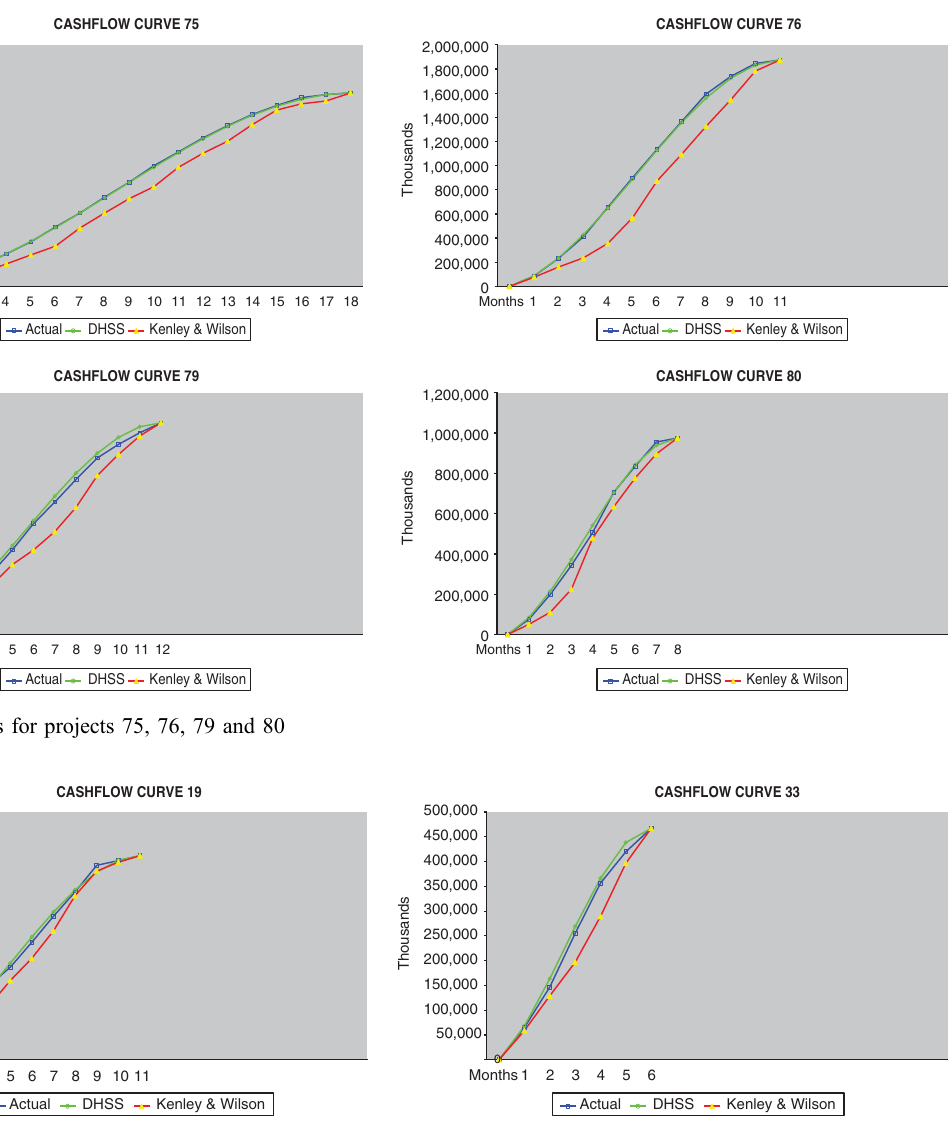
Fig. 5. Cash fl ow curves for projects 19 and